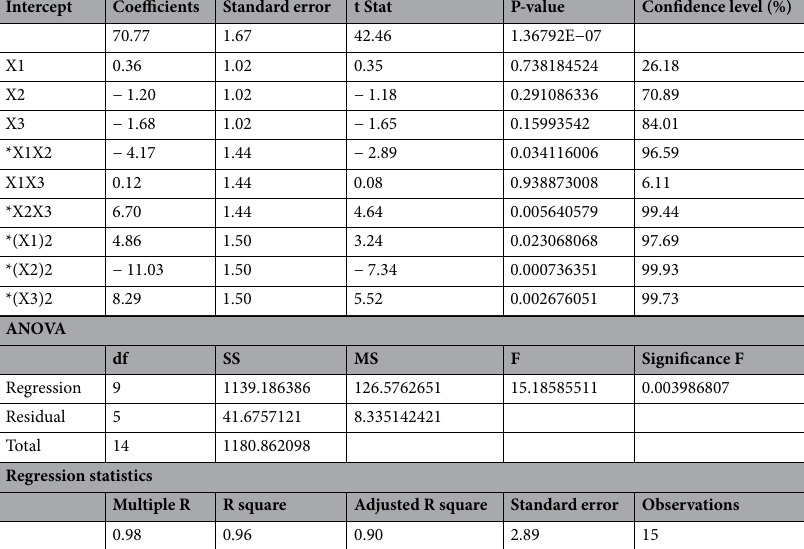
Table 6. Regression statistics and analysis of variance (ANOVA) for Box–Behnken experimental design. *Denotes a confidence level that is statistically significant (the significant variables have confidence levels up to 95%).